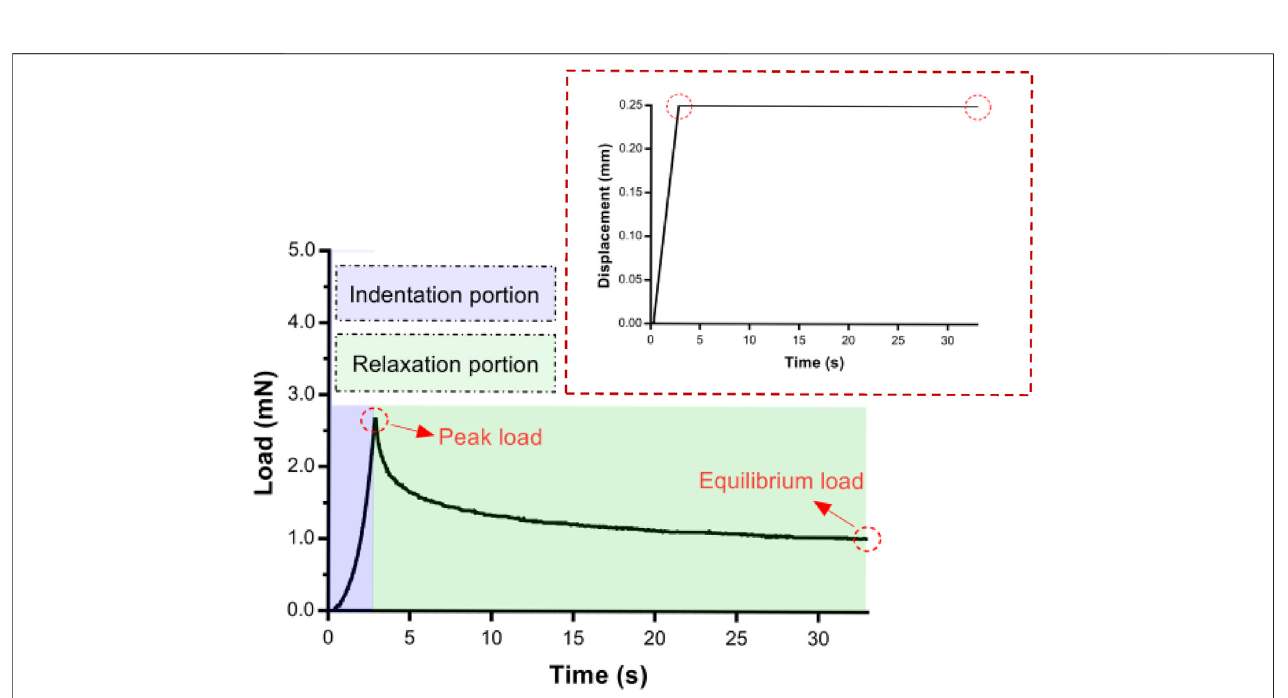
FIGURE 2 | An example of an entire experimental indentation – relaxation load trace for 30 s of 0.50-mm radius indenter. Insert: A typical displacement – time in indentation portion.